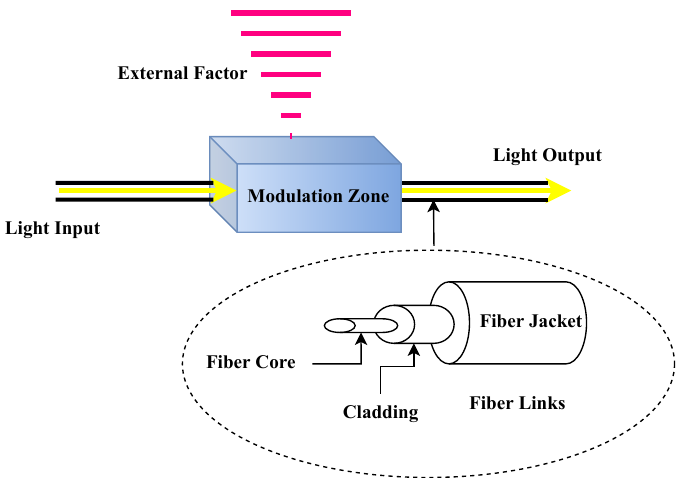
Figure 12. Composition and working principle of a typical FOS